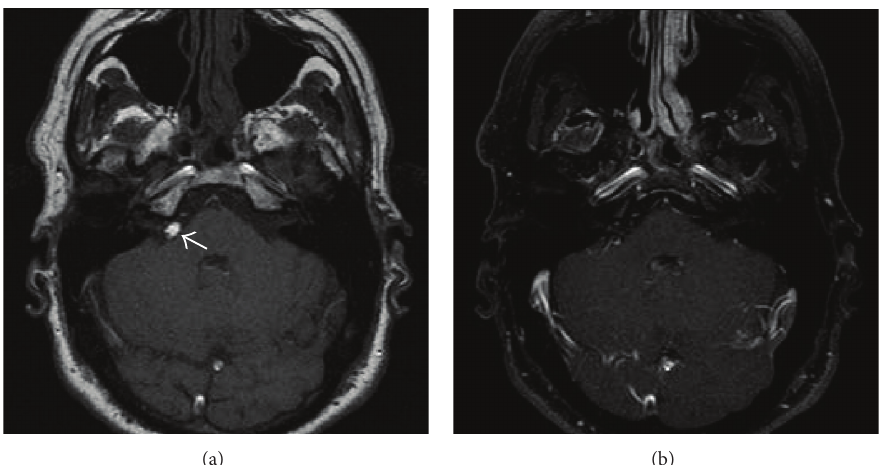
Figure 12: CPA Lipoma. Noncontrast T1-weighted image (a) demonstrates a globular hyperintense lesion in the right CPA (white arrow). (b) Postcontrast fat-saturated T1-weighted MR image shows signal dropout indicating that this lesion is composed of fat. There is no associated enhancement of this